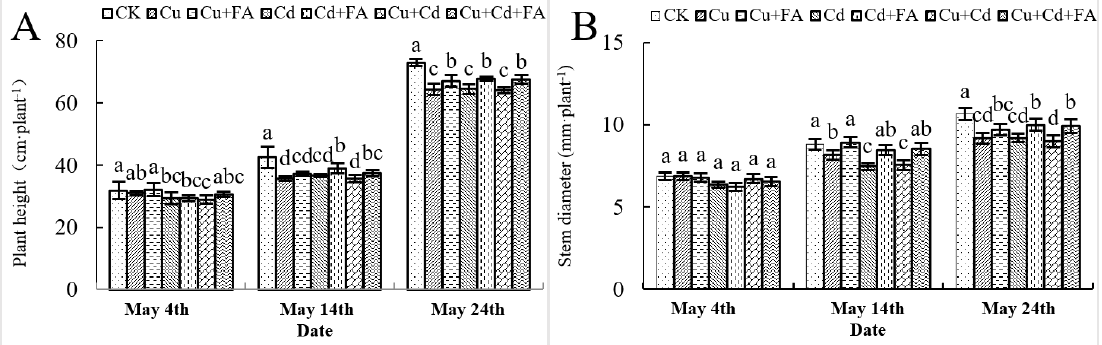
Figure 1. Plant height ( A ) and stem diameter ( B ) of tomato plants under different stresses of Cu, Cd treatments. The same alphabet above each column shows no significance ( p > 0.05), in contrast, having significance ( p <